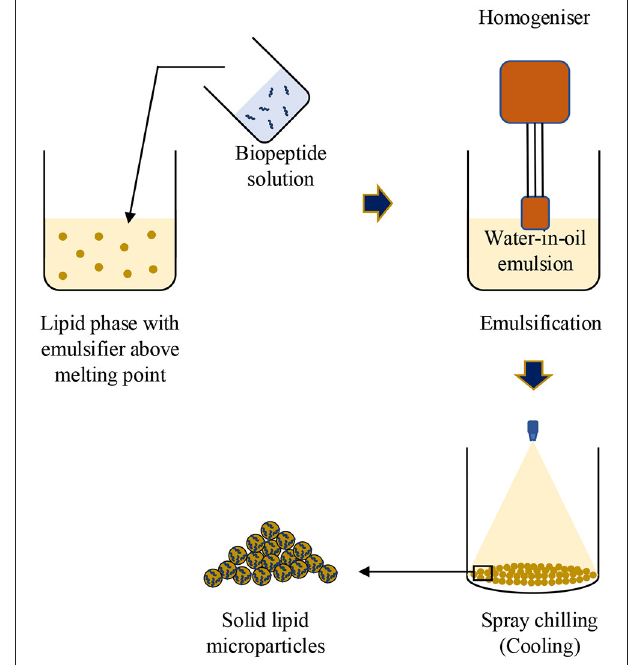
FIGURE 2 | Scheme of preparation of solid lipid microparticles to encapsulate biopeptides.